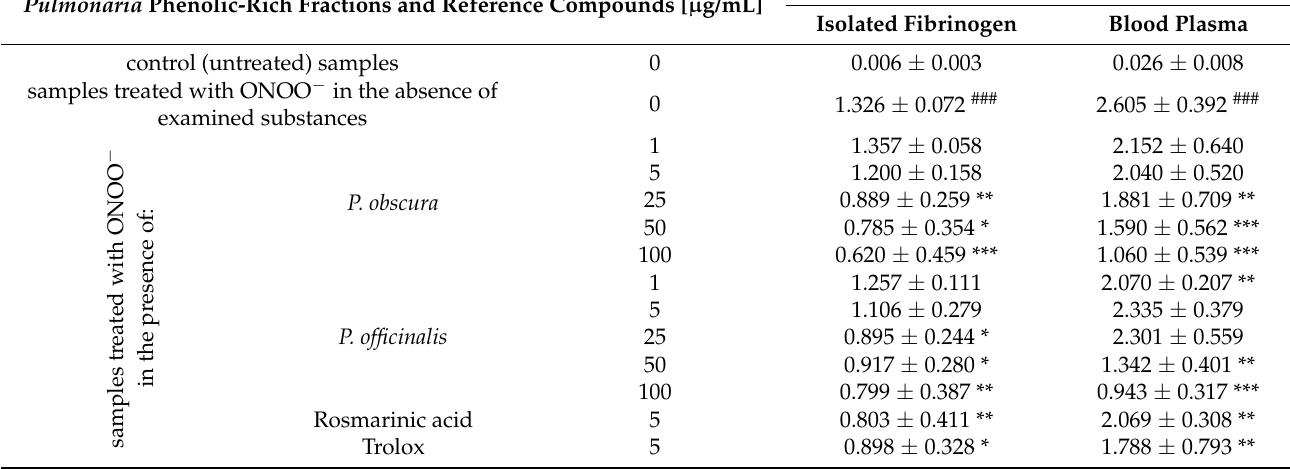
Table 4. Protective effects of the examined Pulmonaria phenolic-rich fractions on the 100 µ M ONOO − -induced nitration of tyrosine residues in human blood plasma proteins and the isolated human fibrinogen (* p < 0.05; ** p < 0.01; *** p < 0.001 for plasma treated with ONOO − in the absence of examined substances vs. plasma treated with ONOO − in the presence of the extracts; ### p < 0.001 for the control samples vs. samples treated with ONOO − in the absence of examined substances; /-per; n = 7).